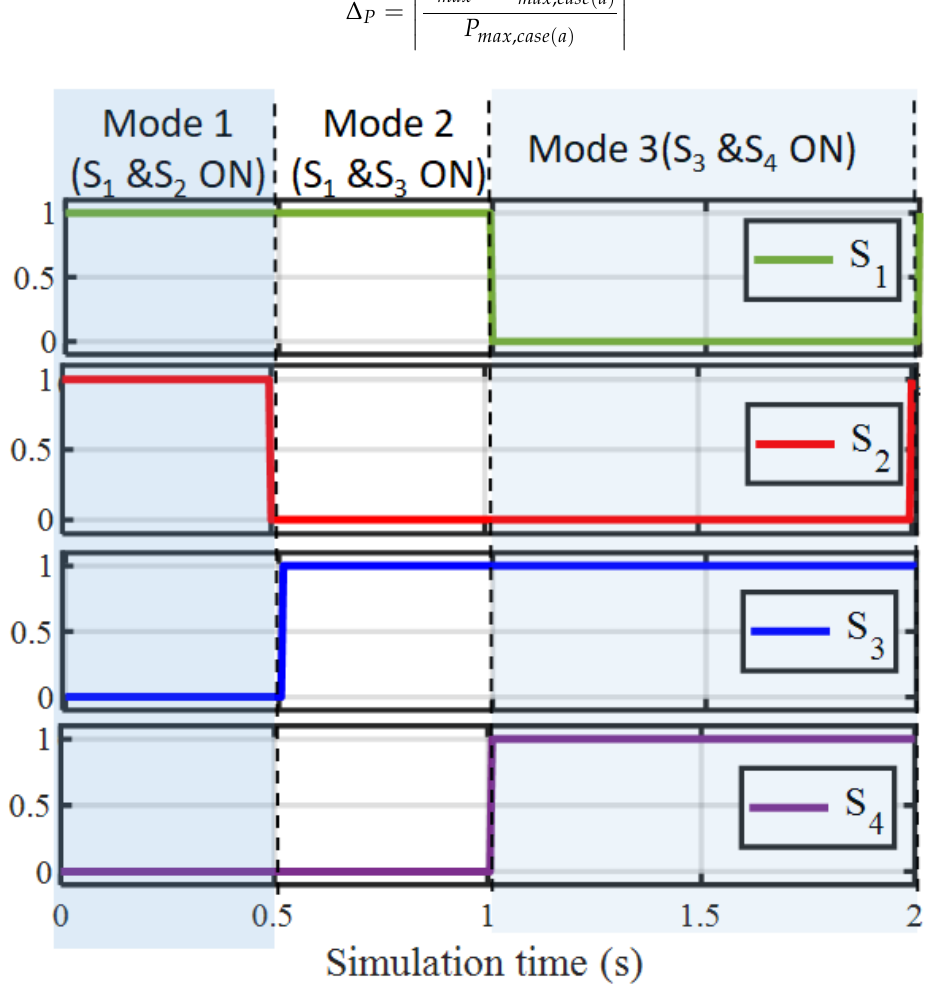
Figure 6. States of the switches as explained in Table